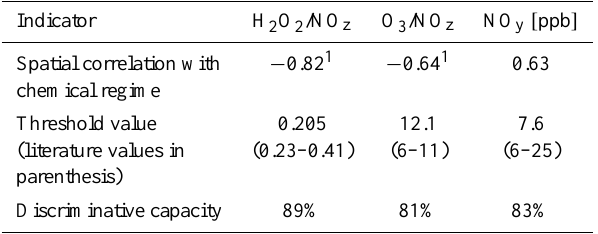
Table 2. Relations between chemical regimes and indicators, aver- aged over summer (May–August) 2001 at